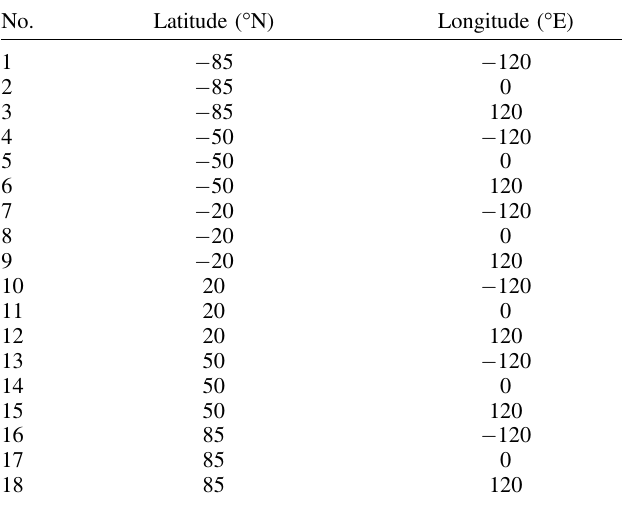
Fig. 2. Location of the 18 grid points used for in the single-point forecasting. Table 2. Coordinates of the 18 grid points used in the single point TEC